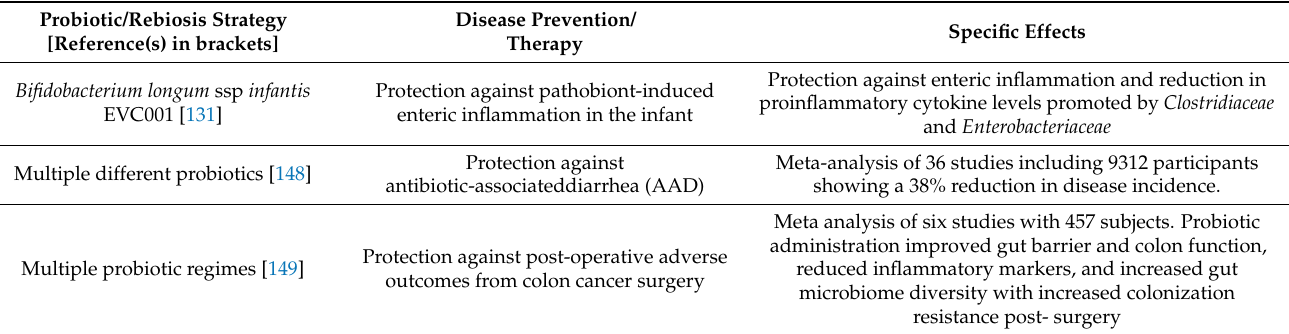
Table 4. Examples of Recent Use of Probiotics/Rebiosis in Disease Prevention and Therapy. Probiotic/Rebiosis Strategy [Reference(s) in